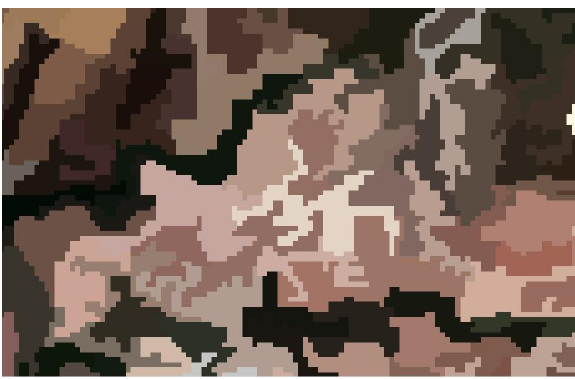
Figure 7. Subset of Sentinel-2A segmented image